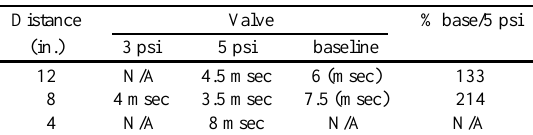
Table 5 Average time over 6 psi –